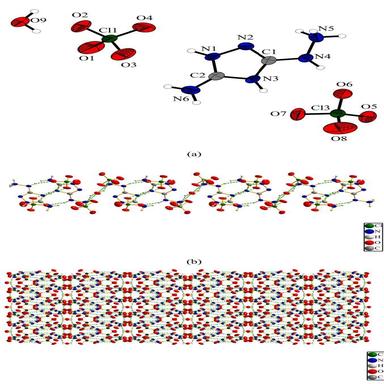
(a) Crystal structure of 2. (b) 1D chain in 2. (c) Packing diagram of 2 along the b-axis.